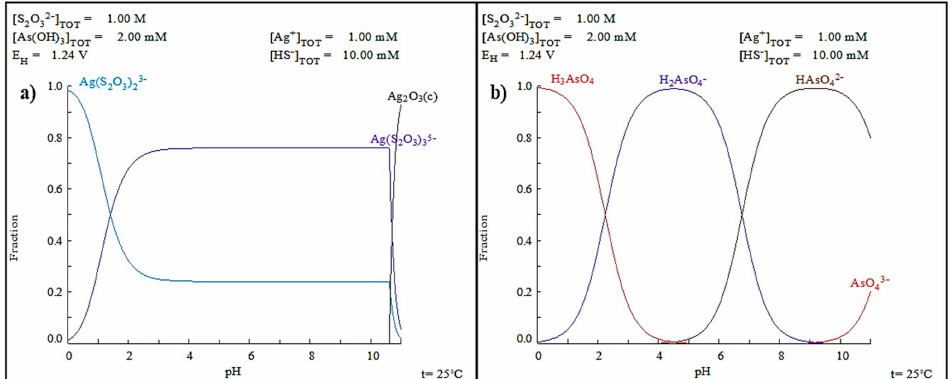
Figure 4. Species distribution diagram ( a ) Ag fraction in relation to pH range. ( b ) As fraction in relation to pH range. [S 2 O 32 − ] = 1 mol · L − 1 , [As(OH) 3 ] = 2 mmol · L − 1 , [Ag + ] = 1 mmol · L − 1 , [HS − ] = 10 mmol · L − 1 , pH = 0 to 14, Eh = − 2 to 2 V.